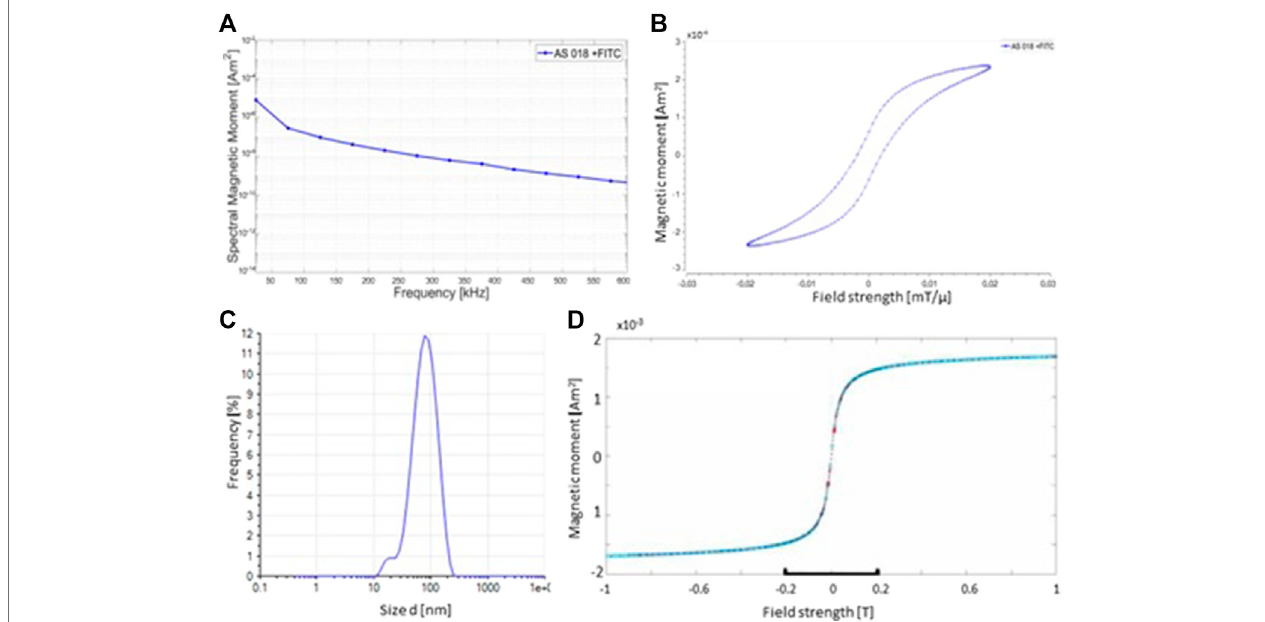
FIGURE 1 | Physical characteristics of synthesized SPIONs. (A) MPS measurement of the SPINOs shows the amplitude spectrum of the odd harmonic. The amplitudespectrum oftheFITC-labelednanoparticlesindicatesagoodsignalresponseforimagingbyMPI. (B) MPSmeasurementsillustratethemagnetizationcurveof the SPIONs. (C) Photon correlation spectroscopy (PCS) measurements of the size distribution of the nanoparticles. The mean hydrodynamic diameter of the used SPIONs is 67.0 nm (D) The magnetic properties of the particles were veri fi ed using a vibrating sample magnetometer (VSM) at room